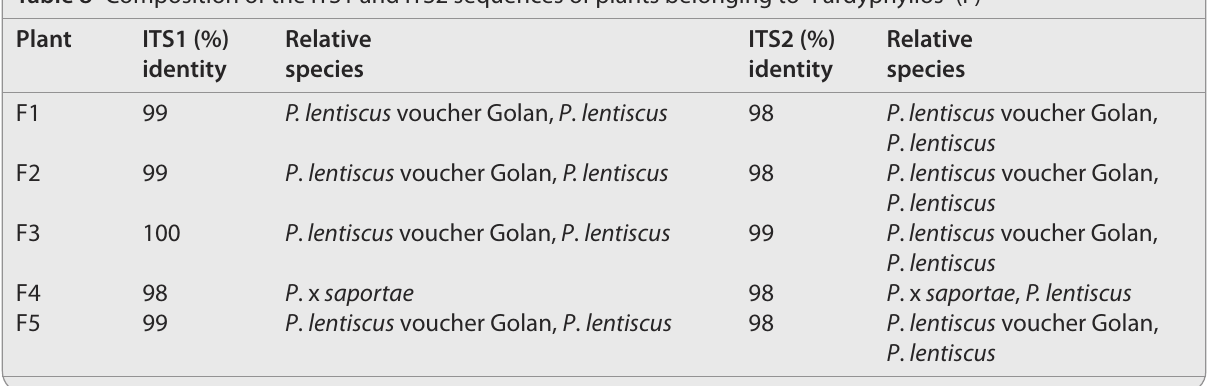
Table 8 Composition of the ITS1 and ITS2 sequences of plants belonging to “Fardyphyllos” (F)